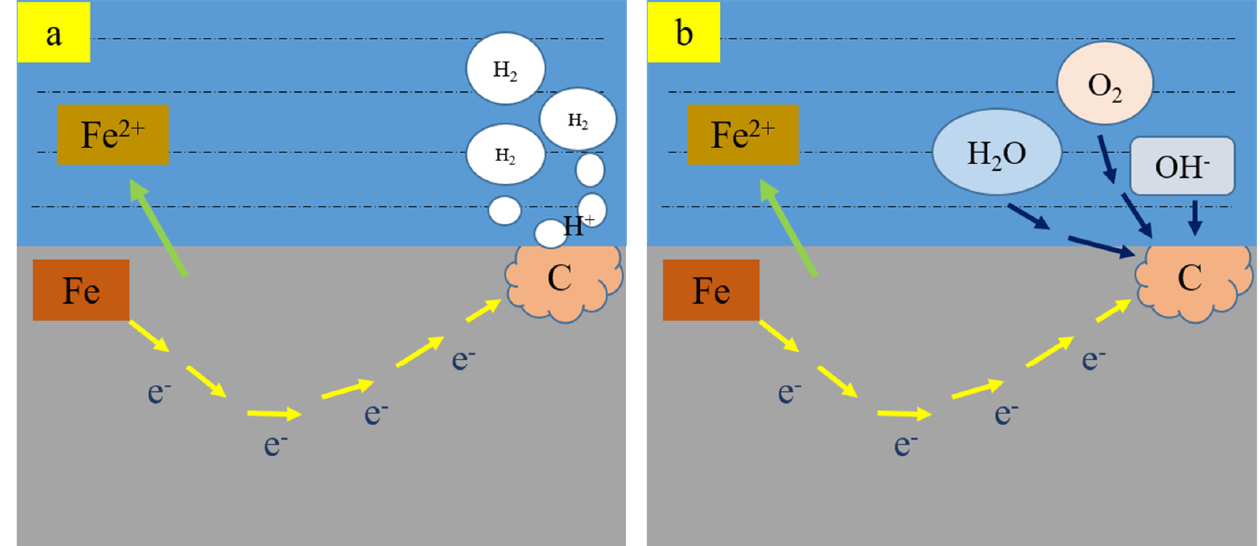
Figure 22. Mechanism of stress corrosive cracking: ( a ) Hydrogen evolution reaction; ( b ) Oxygen- absorption reaction.